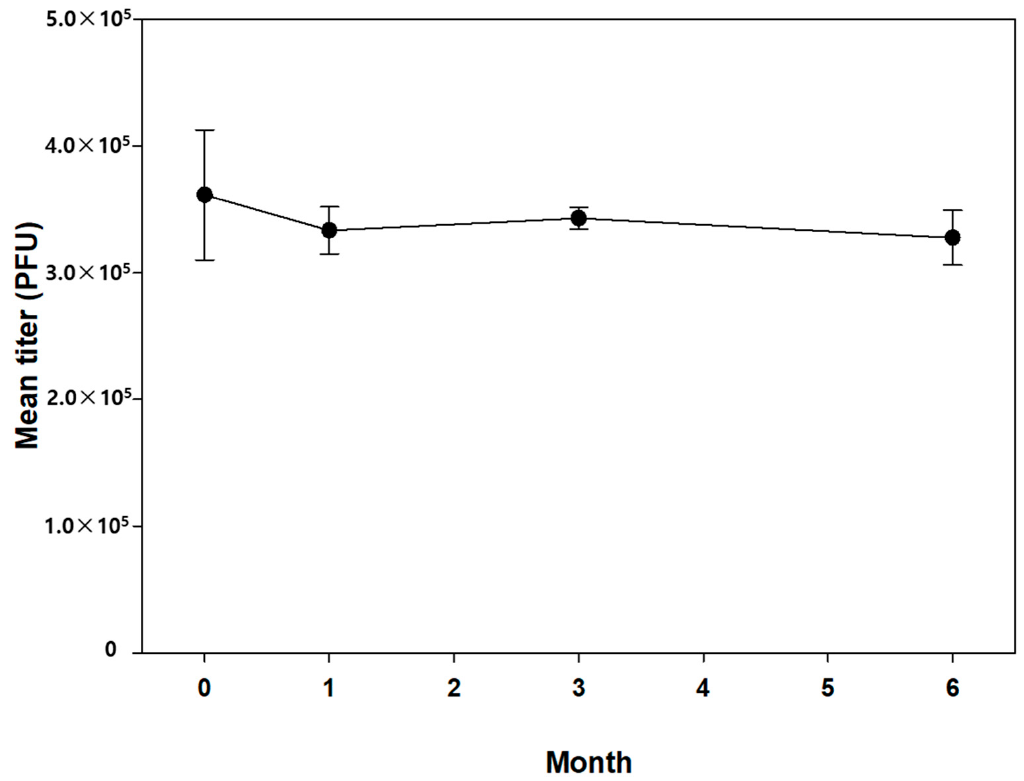
Figure 5. Long-term stability of smallpox-vaccine-coated microneedle stored at − 20 °C. Statistical significance compared to the Day 0 sample was determined by a t -test. There is no statistically significant difference ( p = 0.860).